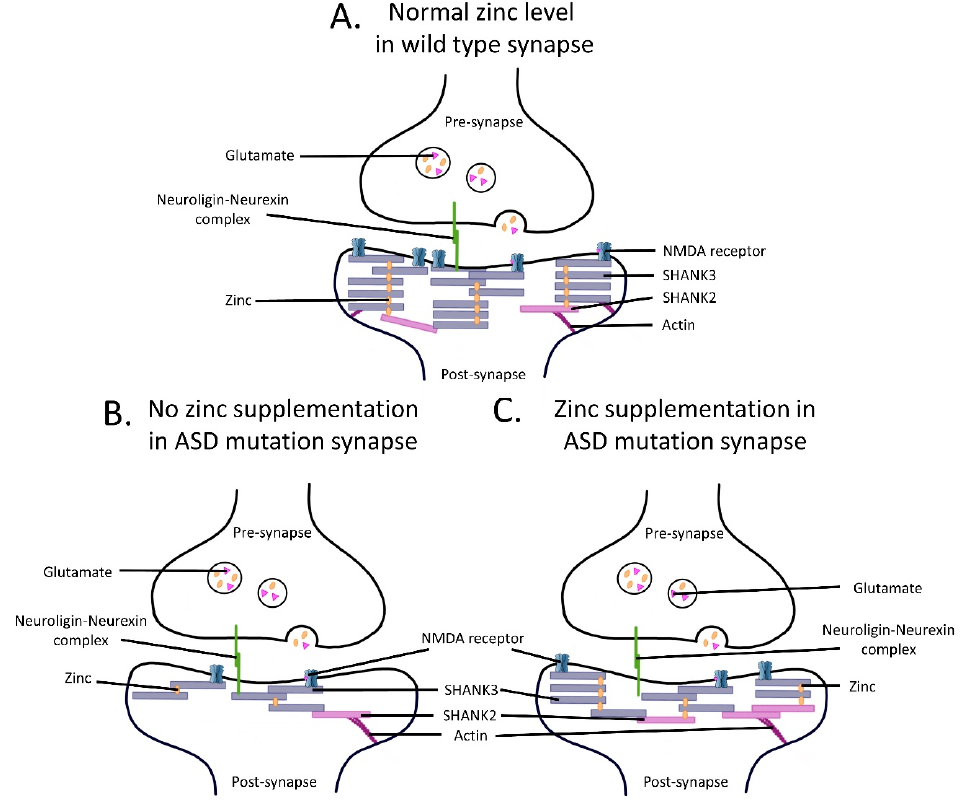
Figure 2. Schematic diagram summarising the positive effects of zinc on glutamatergic synapses through SHANK and recruitment of synaptic proteins, including NMDARs (depicted in blue on the postsynaptic membrane). ( A ) Wild-type synapses are stabilised by the complex organisation of post-synaptic density proteins, including the SHANK scaffold proteins. SHANK proteins link membrane receptors, such as NMDARs, to the actin cytoskeleton. Furthermore, the binding of neuroligin-neurexin complexes to SHANK proteins in the postsynapse enables trans-synaptic signals to the pre-synapse to co-ordinate synaptic plasticity. Zinc maintains the complex organisation of the SHANK proteins in the postsynapse. ( B ) ASD mutation effects on glutamatergic synapses. Depletion of zinc induces the disintegration of SHANK protein complexes, thereby weakening and destabilising the glutamatergic synapse. ( C ) Zinc supplementation can restore the function of the postsynapse by recruiting and stabilising SHANK protein